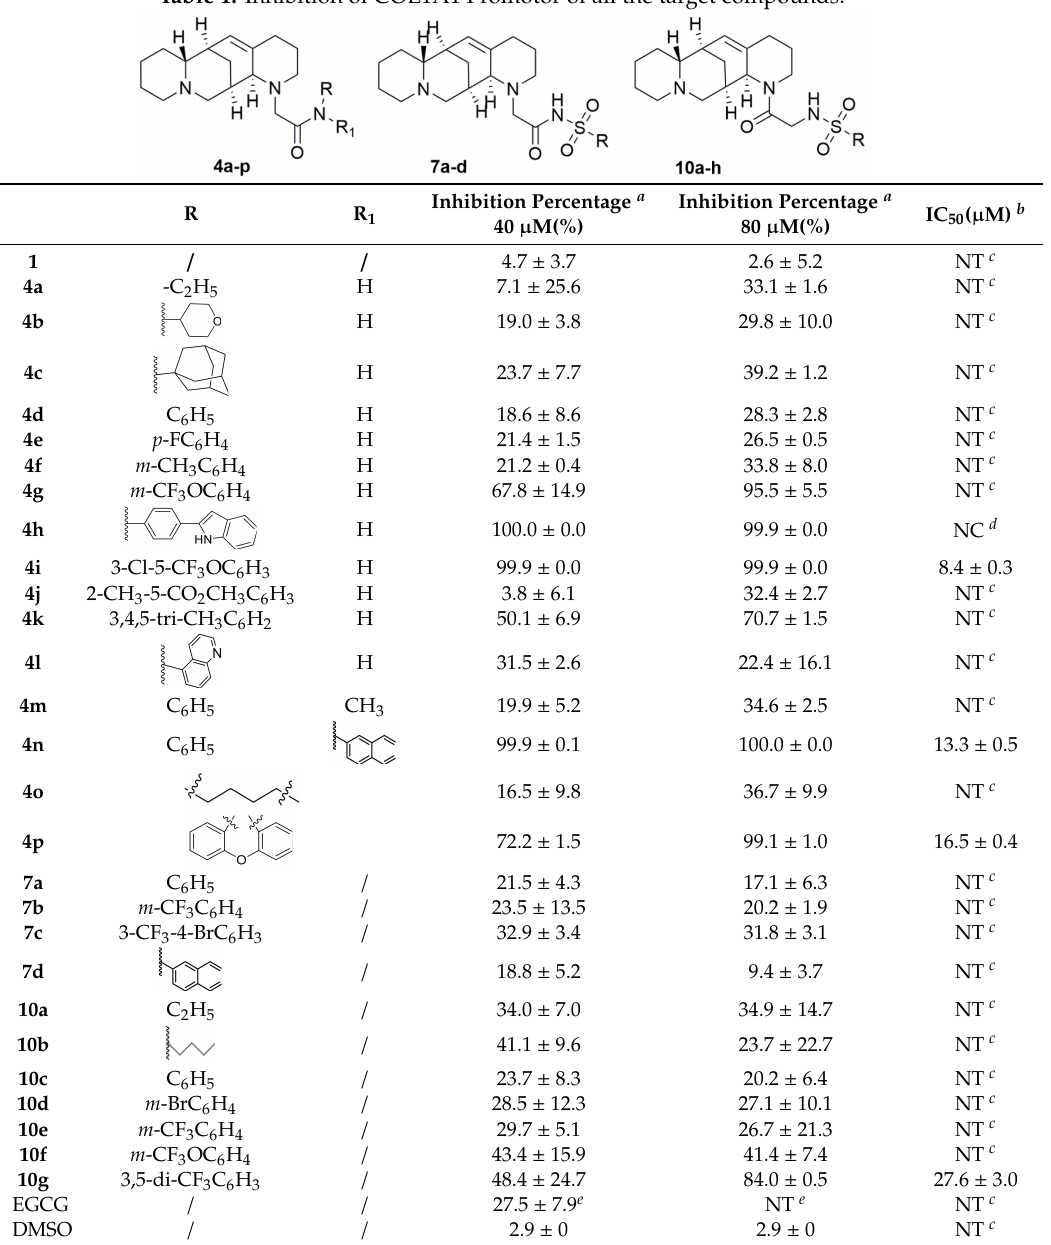
Table 1. Inhibition of COL1A1 Promotor of all the target